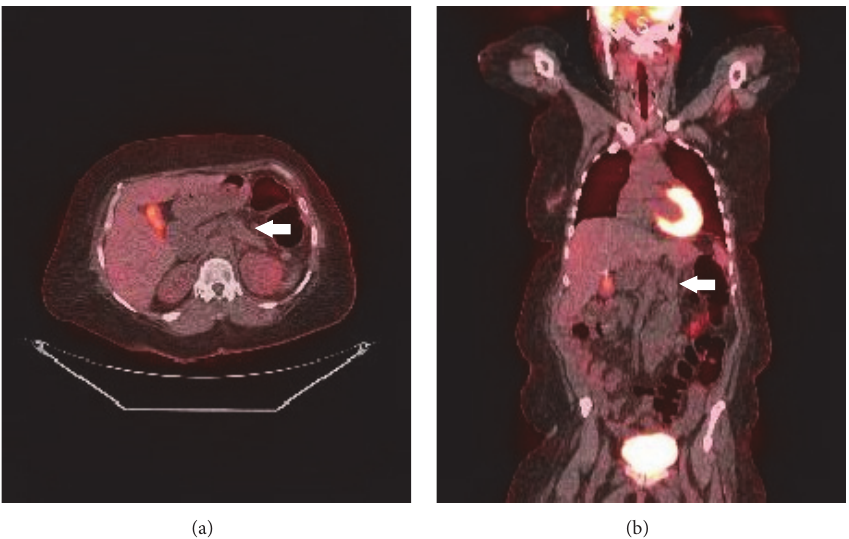
Figure 3: PET-CT ((a) axial, (b) coronal) images showing lack of FDG-avid uptake in pancreas after neoadjuvant chemoradiation.